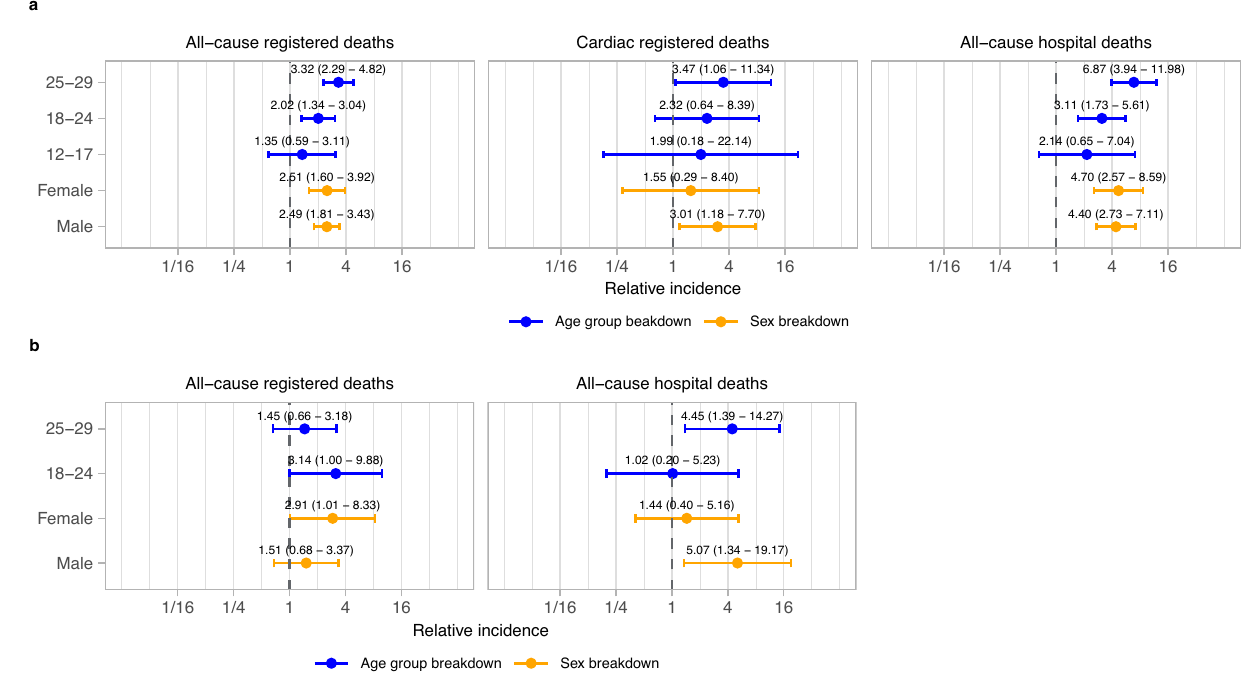
Fig.4|Relativeincidenceofcardiacandall-causedeathintheriskperiodafter SARS-Cov-2 positive test, compared to the baseline period, by sex and age group. Data are presented as incidence rate ratio with 95% con fi dence intervals. Models are adjusted for calendar time. n = 3219 all-cause registered deaths, 369